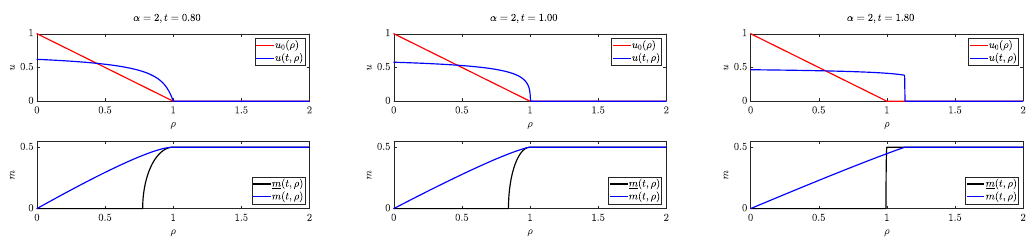
Fig. 6: The explicit Ansatz viscosity subsolution (4.32) guarantees existence of waiting time. The subsolution is represented from the explicit solution, whereas u is computed through the numerical scheme in Section 5. See a movie simulation in the supplementary material [1, Video